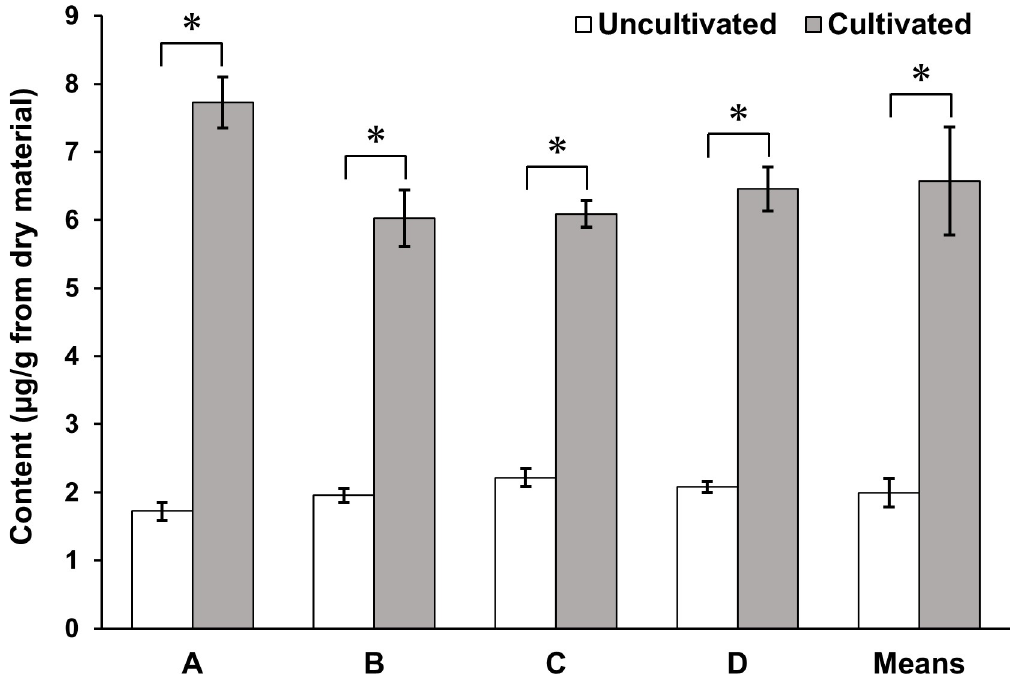
Fig 6. CM content in various commercial soybean sprouts. Sample details and CM contents are shown in Table 3. Four soybean sprouts (products A–D) were used as samples. Samples were either cultivated at 24˚C in light for 1 day and then lyophilized (“cultivated”) or lyophilized immediately (“uncultivated”). Uncultivated and cultivated groups were compared using Student’s t -test, and p < 0.001 was considered statistically significant. CM content was significantly higher in the cultivated groups than in the uncultivated groups; mean CM contents were 6.57 ± 0.79 and 2.00 ± 0.21 μ g/g dry material in the cultivated and uncultivated groups, respectively.